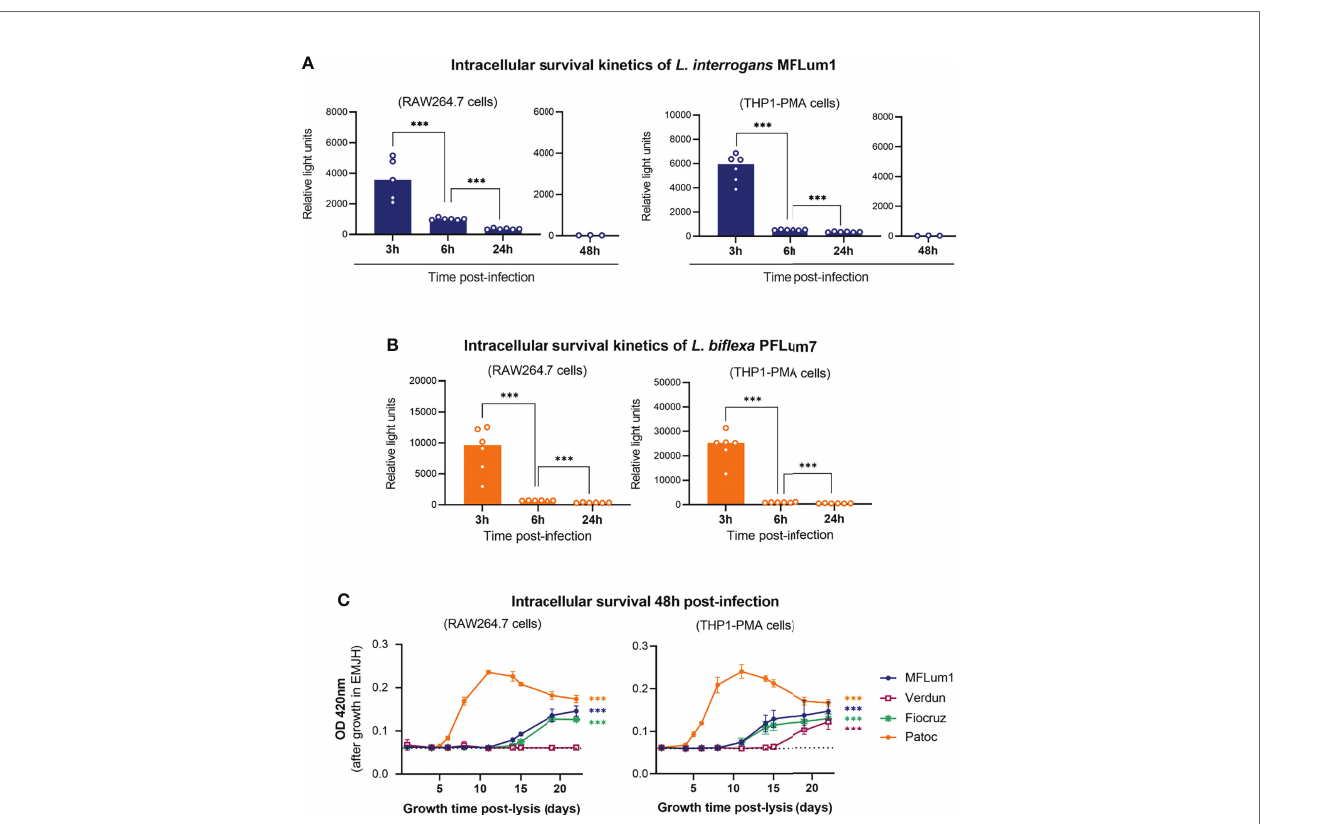
FIGURE 3 | Internalized leptospires do not replicate in macrophages and disappear between 3 and 6 hpi. (A, B) Intracellular survival 3, 6, 24, and 48 h post- infection of (A) L. interrogans serovar Manilae strain MFLum1 and (B) L. bi fl exa serovar Patoc strain PFLum in both RAW264.7 and PMA – differentiated THP1 cells infected during 1 h with subsequent gentamicin protection assay. Intracellular survival was directly assessed by luminescence measurement on cell lysates diluted in EMJH. Bars correspond to mean +/- SD of technical replicates ( n = 6). (C) Intracellular survival 48 h post-infection of L. interrogans serovar Manilae strain MFLum1, serovar Copenhageni strain Fiocruz L1 – 130, serovar Icterohaemorrhagiae strain Verdun, and L. bi fl exa serovar Patoc strain Patoc I in both RAW264.7 and PMA – differentiated THP1 cells infected during 1 h with subsequent gentamicin protection assay. Intracellular survival was indirectly measured by monitoring leptospiral growth from cell lysates diluted in EMJH at OD 420 nm. Dots correspond to mean +/- SD of technical replicates ( n =3). Data presented are representative of at least 3 independent